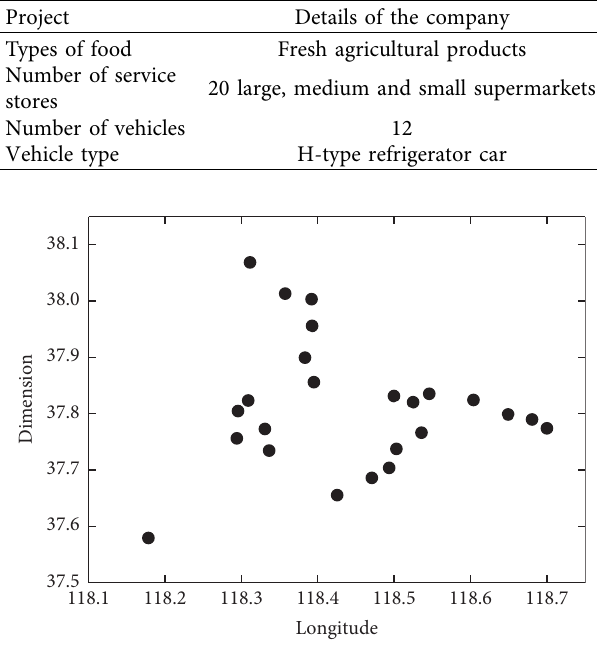
Figure 5: Scatter plot of geographical distribution. Table 2: Longitude and latitude coordinates of alternative distri- bution centers and